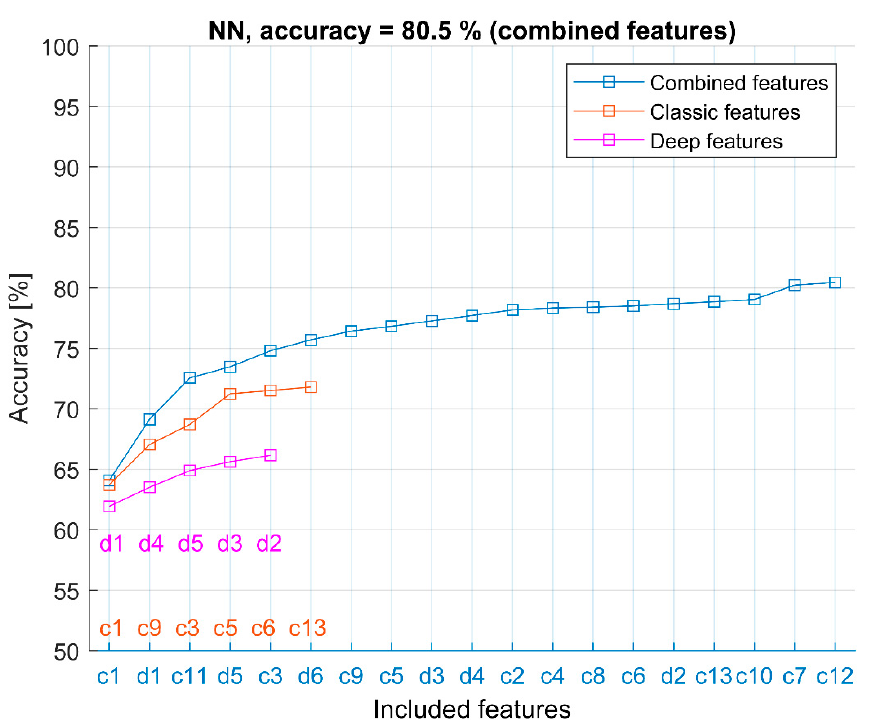
Figure 5. NN classifier and selected combined features (c1, d1, c11, d5, c3, …) in CAE-1 configura- tion “16-32-14-256-6-100-128”.